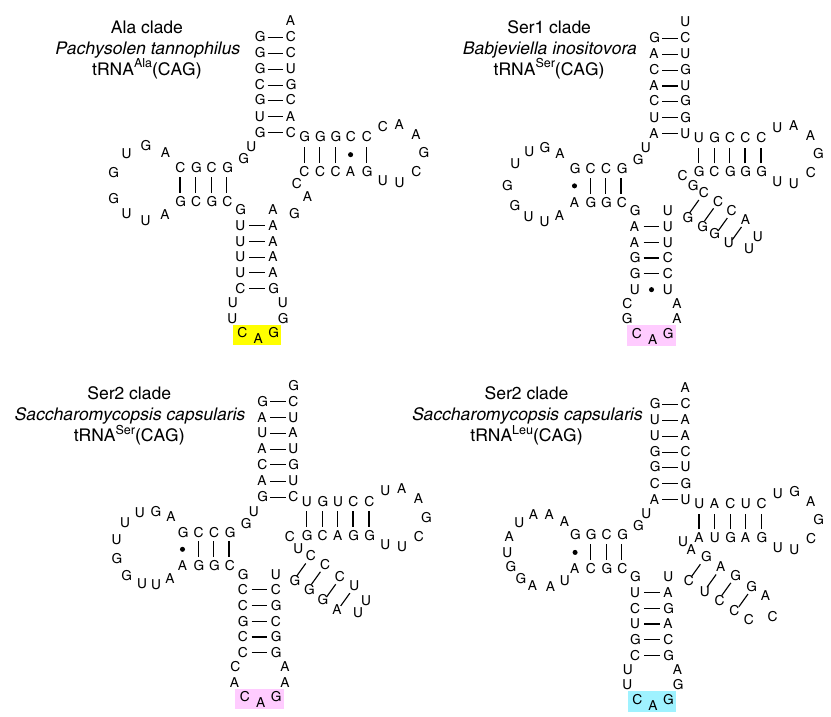
Fig. 3 Cloverleaf structures of representative CUG-decoding tRNAs from the Ala, Ser1, and Ser2